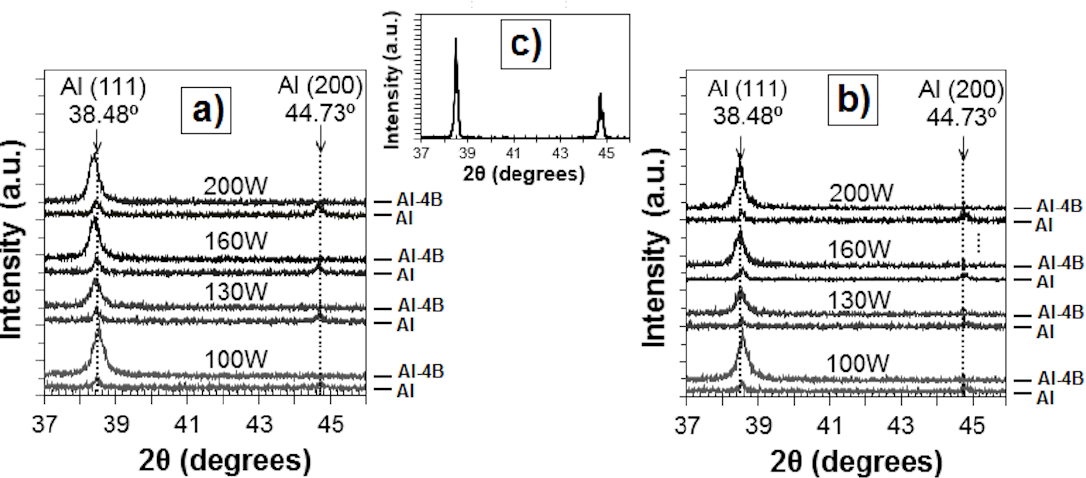
Figure 4. XRD patterns for aluminum films and Al-4B films deposited on ( a ) glass slide and ( b ) Scheme 100, 130, 160, and 200 W), and ( c ) X-ray diffraction pattern obtained from pure aluminum powder sample.